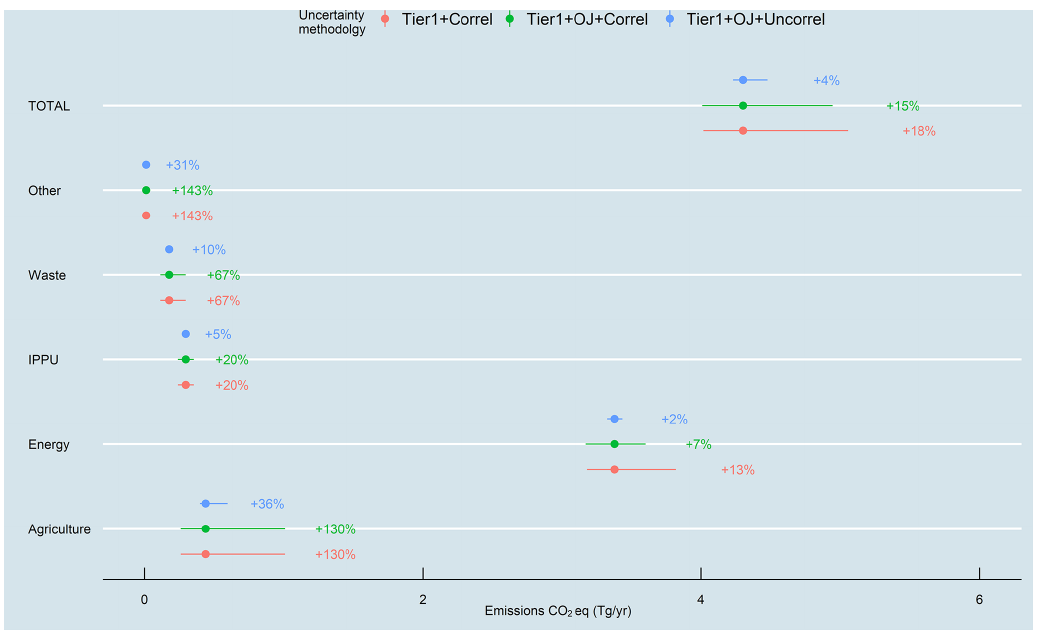
Figure 14. Variability in EU27 + UK emission uncertainty introduced by methodological choices. “Tier 1 + Correl” (in red) is the base case and assumes correlation among subsectors and among sectors across countries and default Tier 1 IPCC-06 uncertainty; “Tier1 + OJ + Correl” (in green) only differs from the base case for the N 2 O uncertainty in sector 1.A ( ± 100% to ± 150%) (green); Tier1 + OJ + Uncorrel (in blue) differs from the base case as it assumes no correlation as well as N 2 O uncertainty in sector 1.A in the range from ± 100% to ±